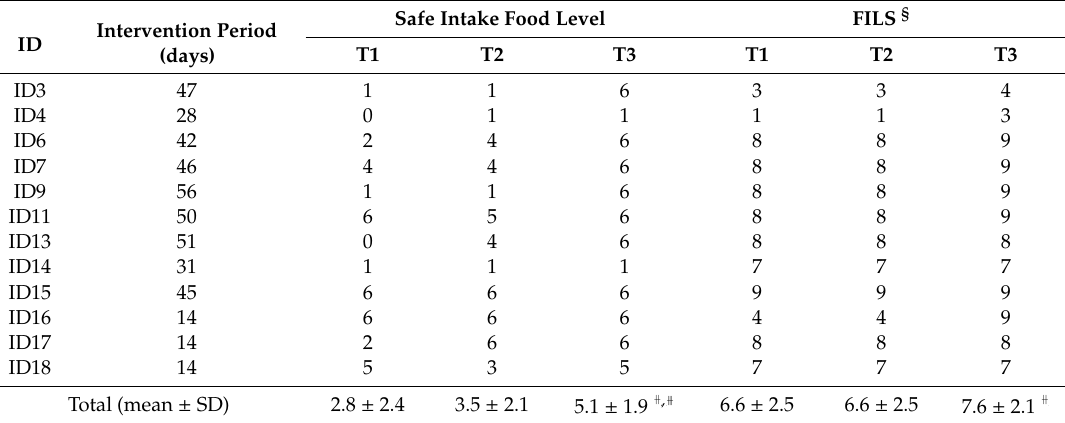
§ Algorithm: Recommended swallowing care based on the ultrasound-based algorithm. Table 3. Safe oral intake scores during the experiment ( n = 12).